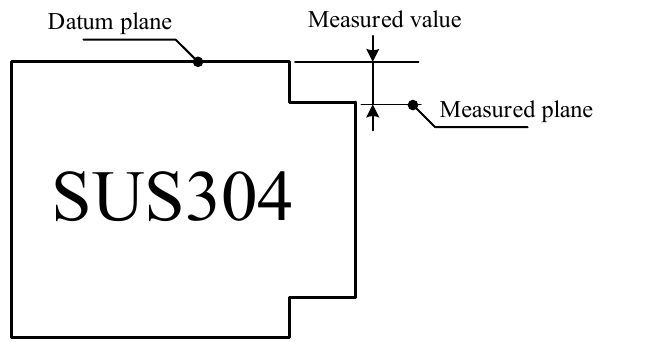
Figure 4. Dimensional measurement.